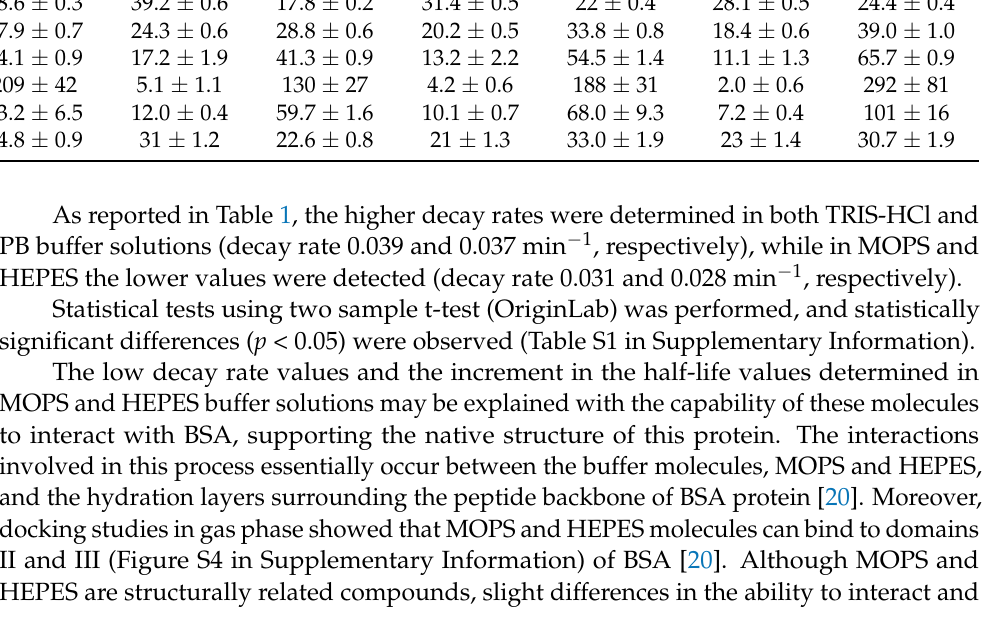
Table 1. Decay rate and half-life values of UV denaturation of tested protein determined acquiring 50 consecutive repeated scans.